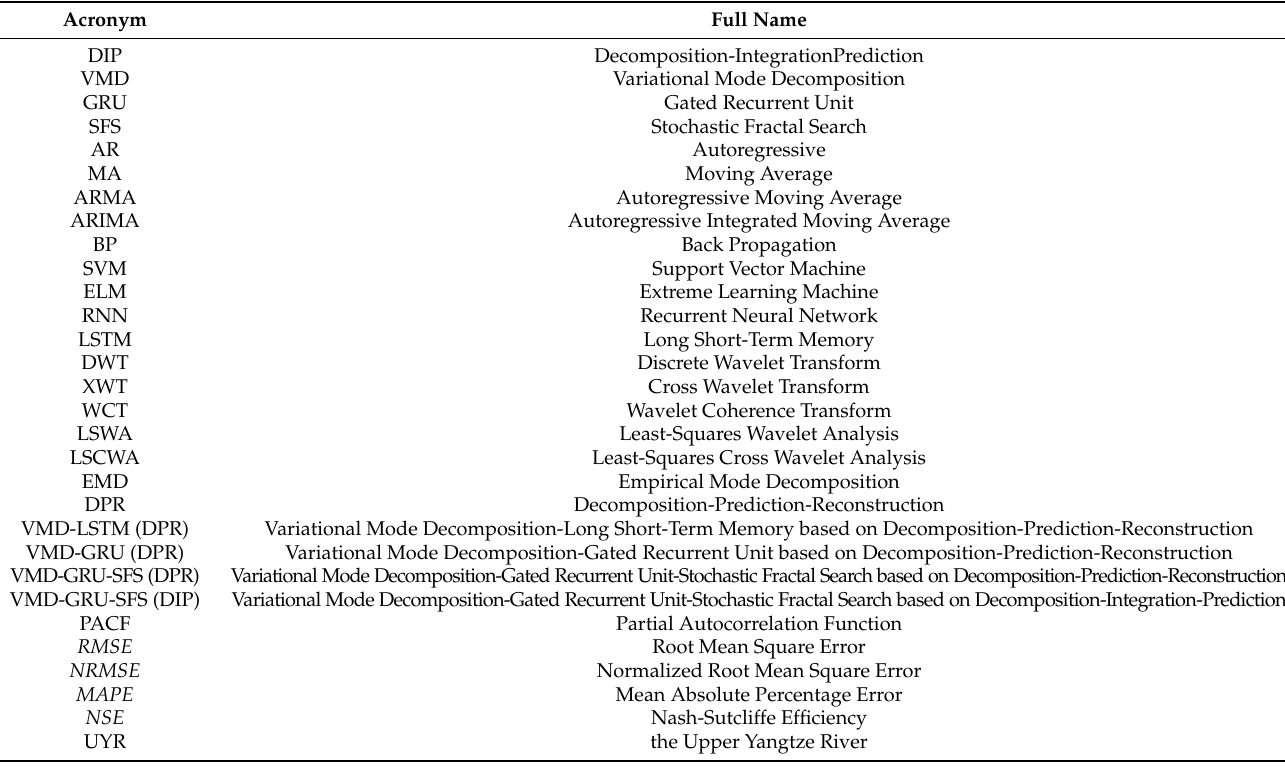
Table A1. Abbreviation